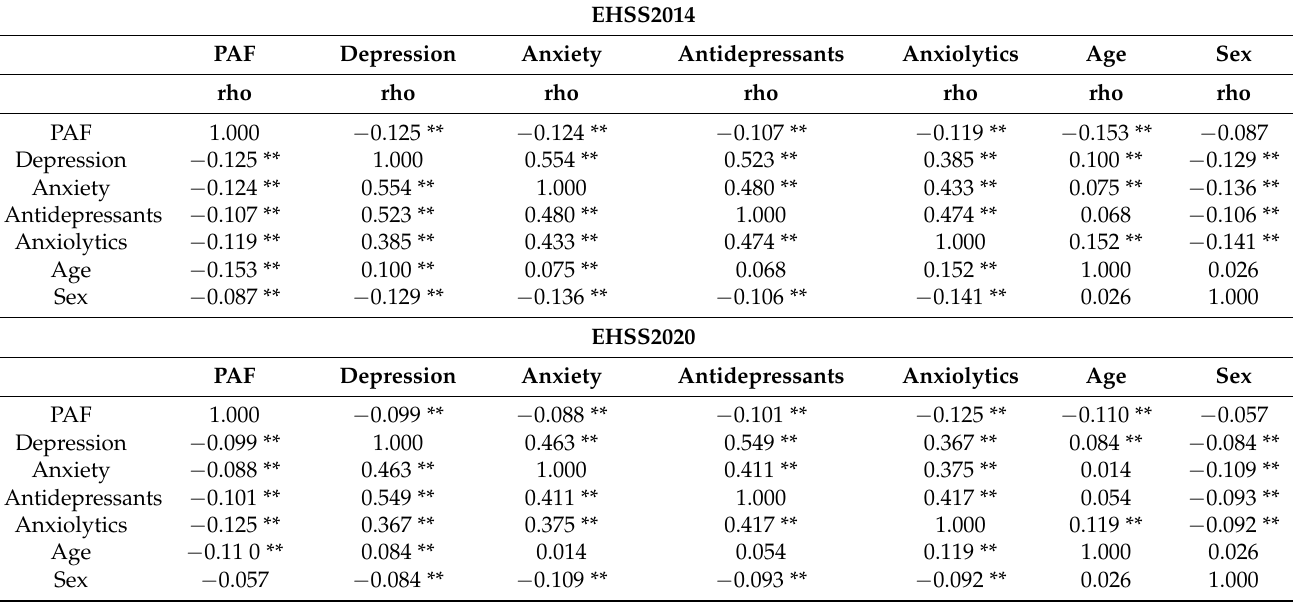
Table 3. Spearman’s bivariate correlation between the depression and anxiety proportions and physical activity frequency, age and sex